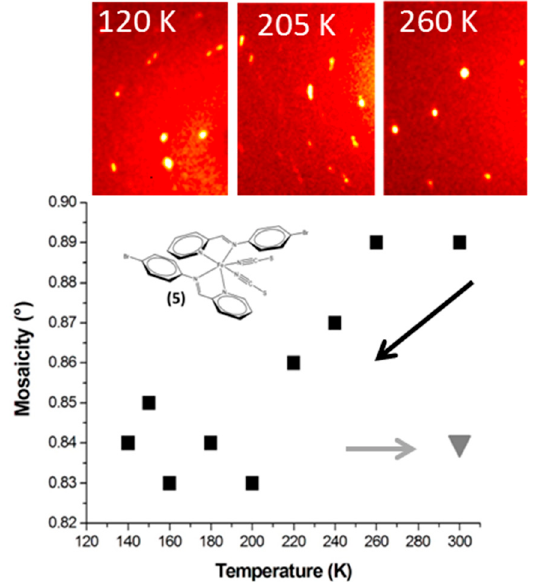
Figure 5. Temperature dependence of the mosaicity of [Fe(PM-BrA) 2 (NCS) 2 ] in the cooling mode, with diffraction images at 120 K (LS), 205 K (mixture HS/LS) and 260 K (HS). Full squares mark the cooling mode and the grey triangle the value when returned to room temperature.